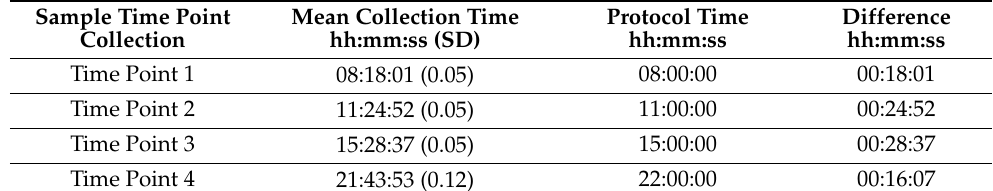
Table 4. Mean sample collection times compared to protocol times and mean